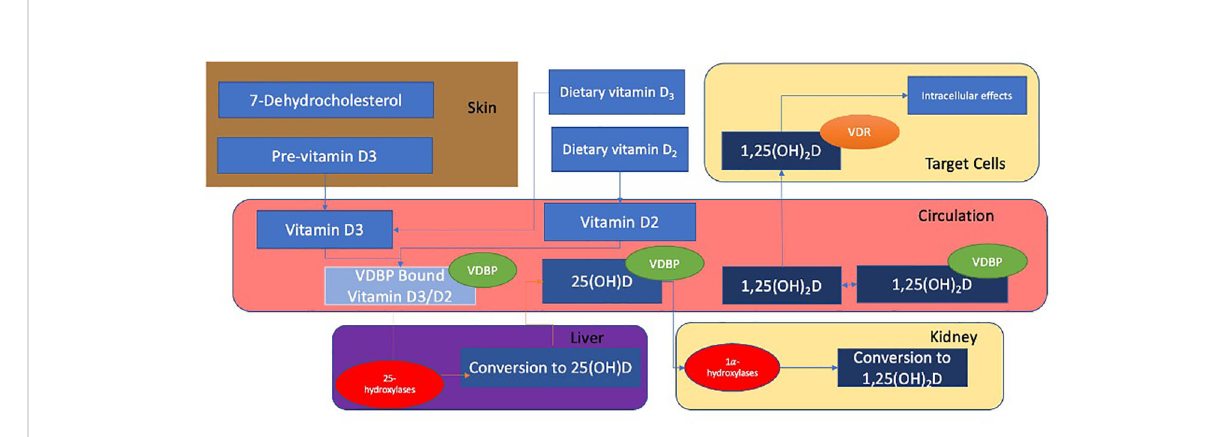
FIGURE 1 Vitamin D 2 is synthesised from ergosterol found in yeast and fungi (17). Ultraviolet B (UVB) rays act on 7-dehydrocholesterol to form previtamin- D 3 in the skin which subsequently undergoes a temperature-dependant isomerisation to vitamin D 3 . Vitamin D binding protein (VDBP) transports vitamins D 2 and D 3 to the liver where they undergo 25-hydroxylation to calcidiol (also known as 25(OH)D). This is mediated by 25 hydroxylases such as CYP2R1 (21). 25(OH)D is bound to VDBP and transported to the kidney, where it is fi ltered through the glomerulus and subsequently reabsorbed into the renal proximal tubular epithelium. This reabsorption occurs through endocytosis and is mediated by the cell surface receptors megalin and cubulin (22). 25(OH)D undergoes 1 a -hydroxylation in the kidney and is converted to calcitriol (also known as 1 , 25 -( OH )2D), the active metabolite of 25(OH)D (22, 23). This is mediated by alpha hydroxylases, (such as CYP27B1). 25(OH)D and 1,25(OH) are inactivated by CYP24A1 in the kidneys